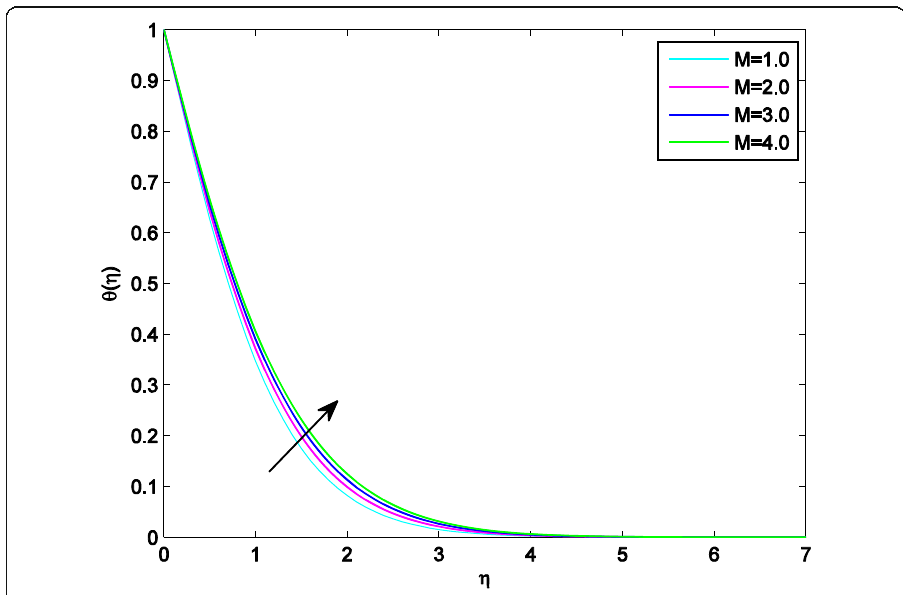
Fig. 4 Temperature graph for various values of